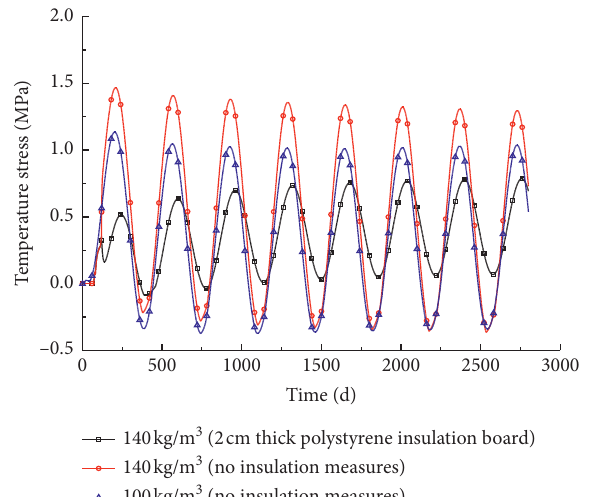
Figure 13: Temperature stress duration curves at K5 under dif- ferent conditions.